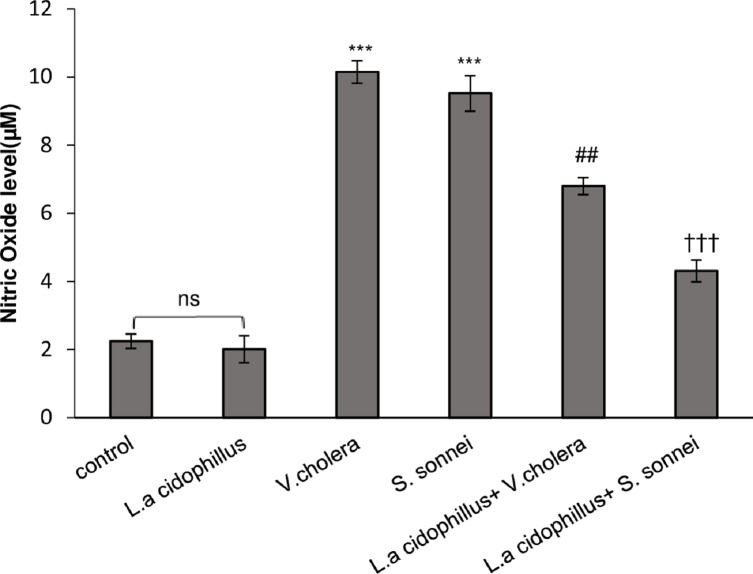
NO level in Caco-2 cells after L. acidophilus pretreatment and followed by V. cholerae/ S. sonnei.NO production after 24h, significantly decreased in comparison with V.cholerae/ S. sonnei infected cells alone. The mean of three independent experiments is shown. The significant differences were notabled when P <0.05. (***P <0.001) significantly different from control cells. ##significantly different of L.a+V.c+Caco-2 from V.c+Caco-2 cells. ††† significantly different of L.a+S.s+Caco-2 from S.s+Caco-2 cells L.a: Lactobacillus acidophilus, V.c: Vibrio cholerae and S.s: Shigella sonnei. ns: none significant.